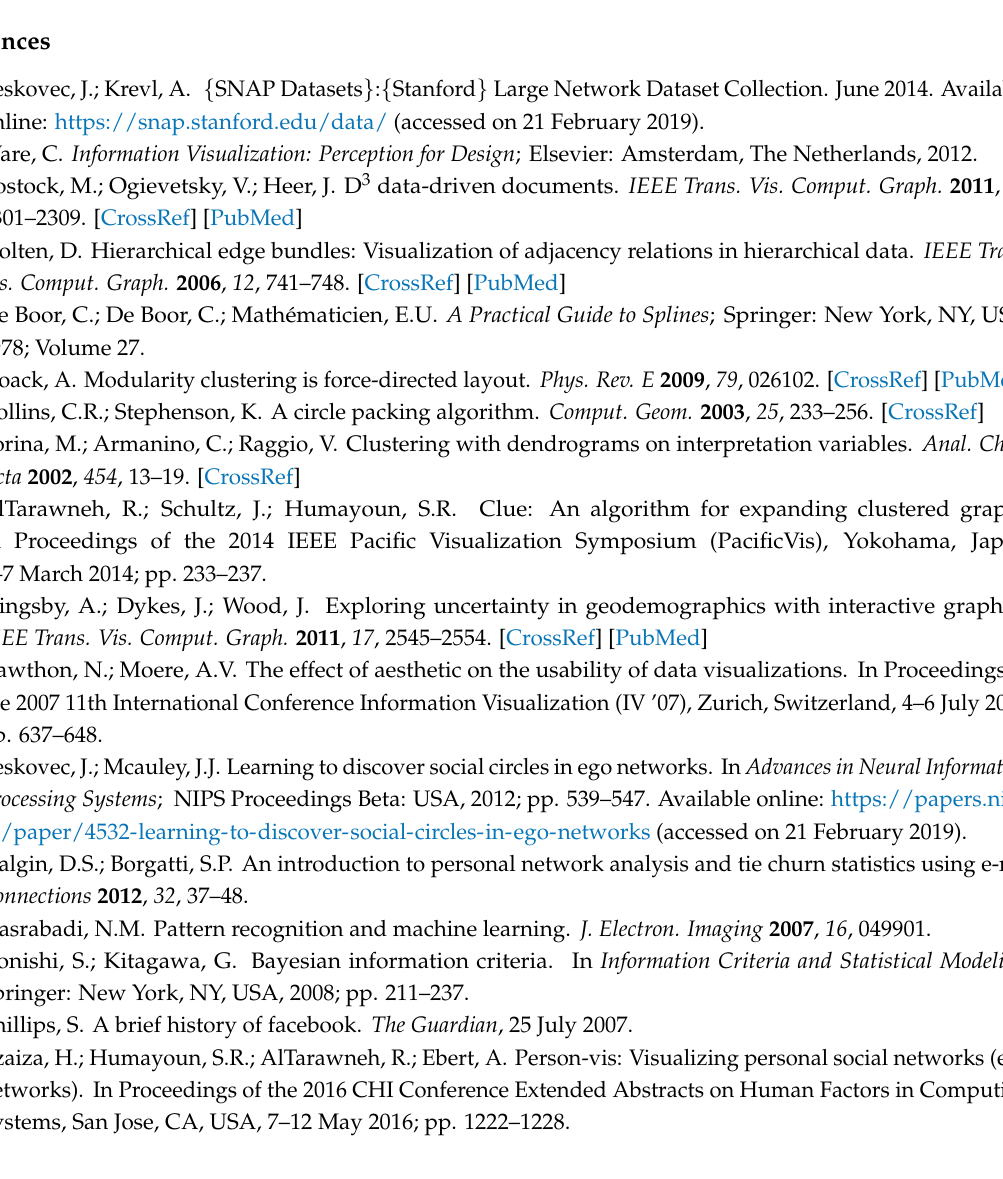
Figure A16. Representation of a graph using hierarchical edge bundling visualization with high bundling